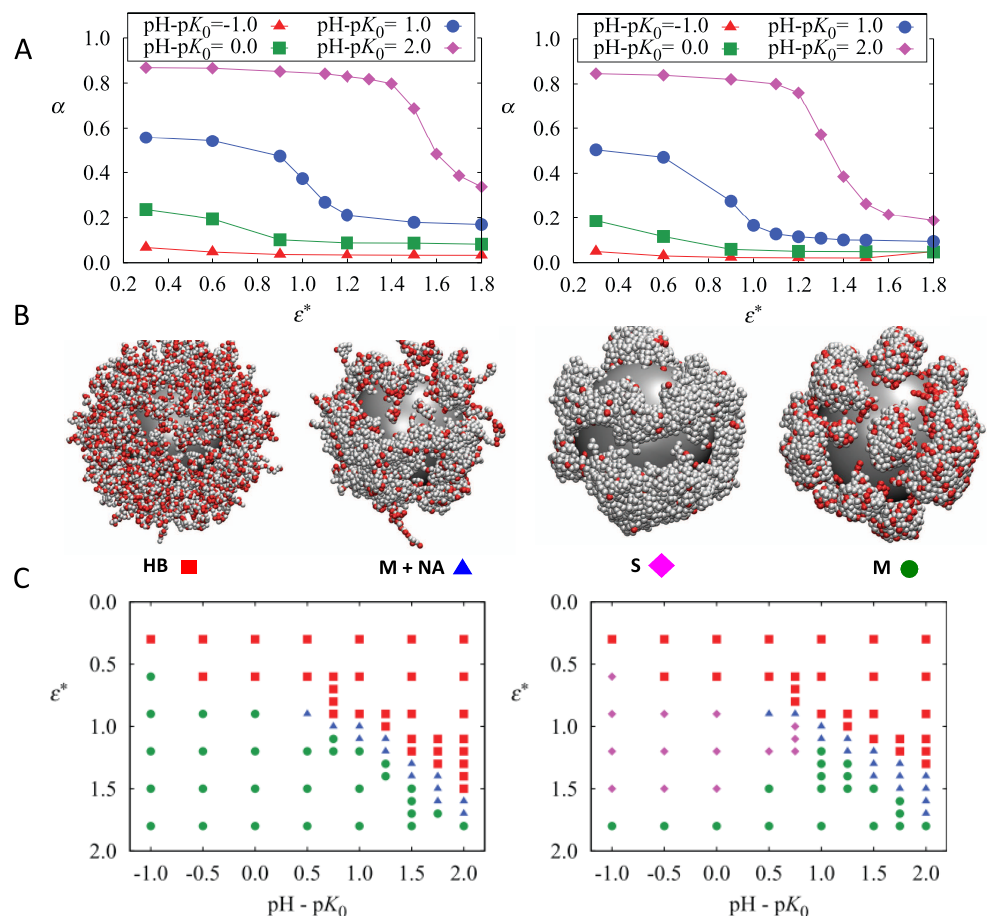
Figure 2. ( A ) Ionization fraction as a function of attraction strength for different values of pH − pK 0 . Upper and lower figures correspond to grafting densities σ = 0.2 nm − 2 and σ = 0.6 nm − 2 , respectively. ( B ) Examples of the four observed polymer morphologies (from left to right): homogeneous brush, micelles plus non-aggregating chains, stripes, and micelles. Charged (unprotonated) monomers are shown in red and uncharged in light gray. Salt ions are omitted. ( C ) Morphology diagrams as a function of attraction strength and pH - pK 0 for a nanoparticle (NP) grafted with weak polyacid chains and σ = 0.2 nm − 2 (left) and σ = 0.6 nm − 2 (right). Red squares indicate a homogeneous brush, green circles indicate micelles, blue triangles indicate micelles plus non-aggregating chains, and purple diamonds indicate stripes. (Reprinted with permission from the authors of [70]. Copyright 2012 American Institute of